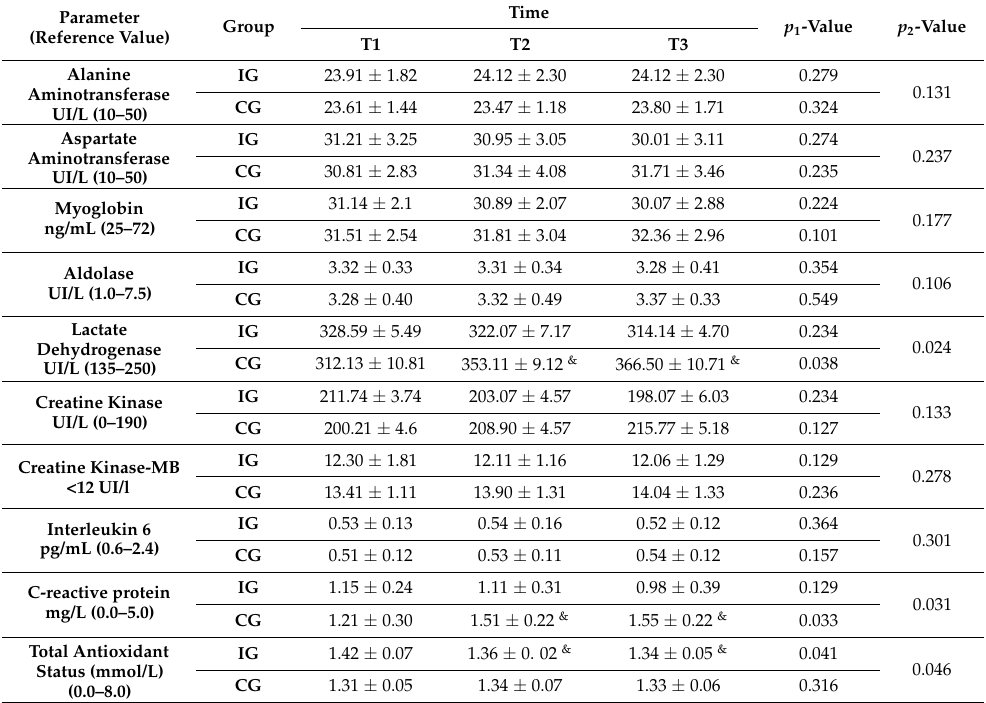
Table 2. Muscle damage enzymes, inflammation biomarkers, and antioxidant status in the interven- tion group (IG n = 15) and in the control group (CG n = 15), in the three moments of the study. Parameter (Reference